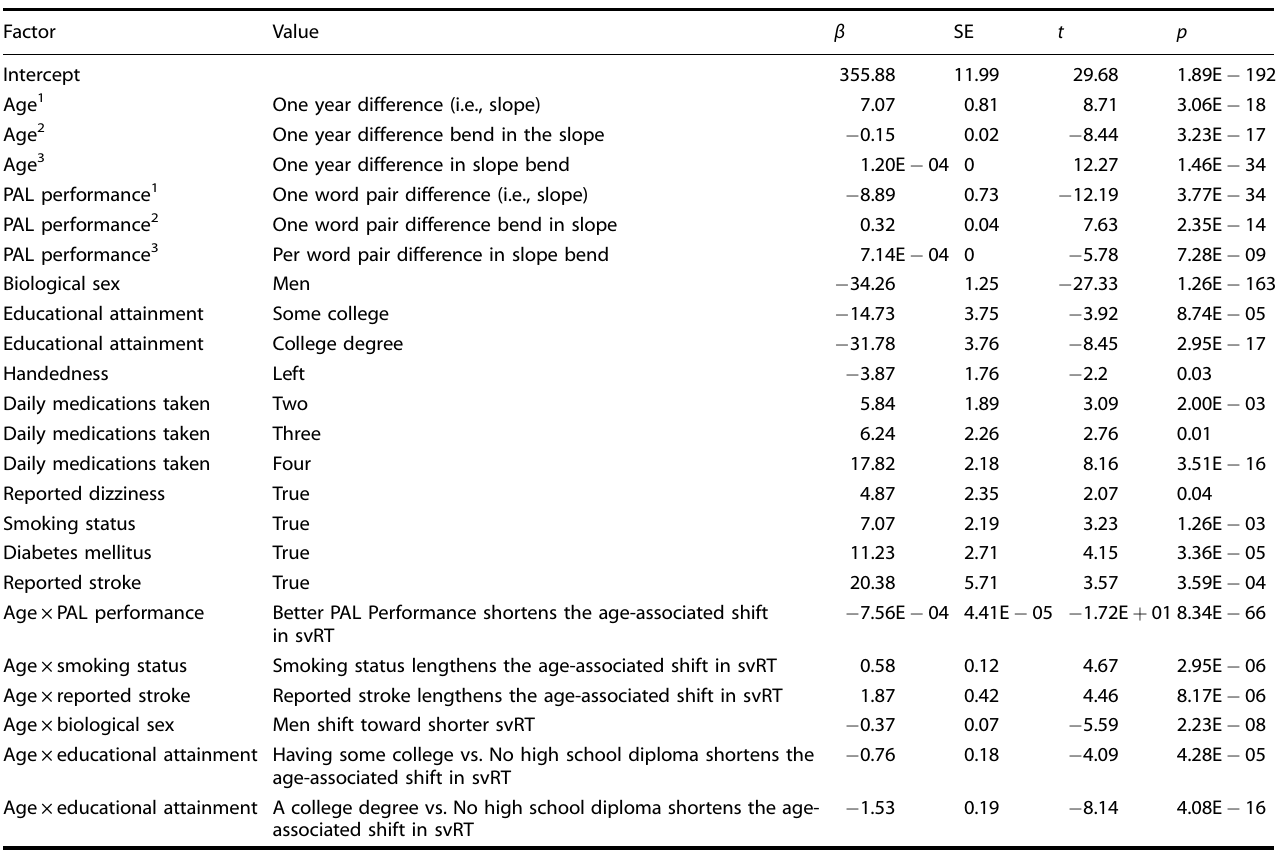
Table 3. Summary MindCrowd ’ s main